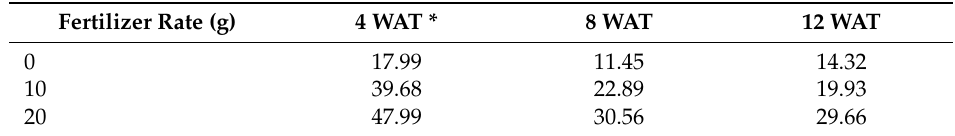
Table 4. Leaf total N concentration (mg − 1 g dw) at di ff erent fertilizer rates at three sampling times 4, 8, and 12 WAT in Justicia brandegeana . Values are from combining five mature leaves and no petioles from five di ff erent pots per treatment for a single composite sample ( n =